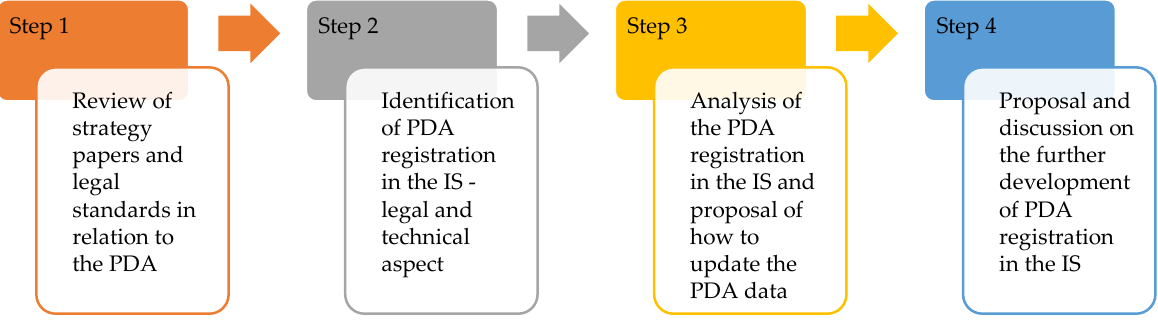
Figure 1. The methodology flowchart. 113